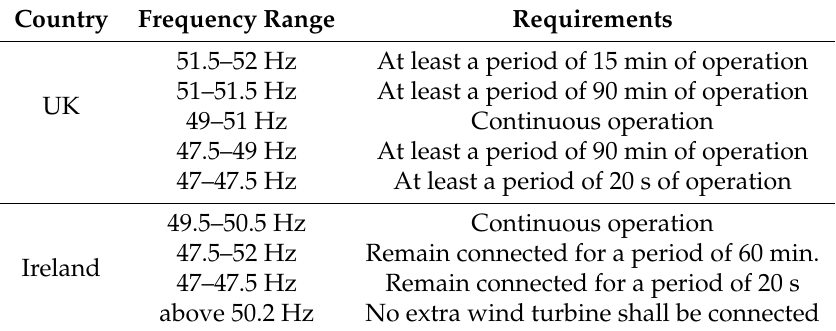
Table 3. Frequency ranges and the corresponding requirements in the UK [147] and Ireland